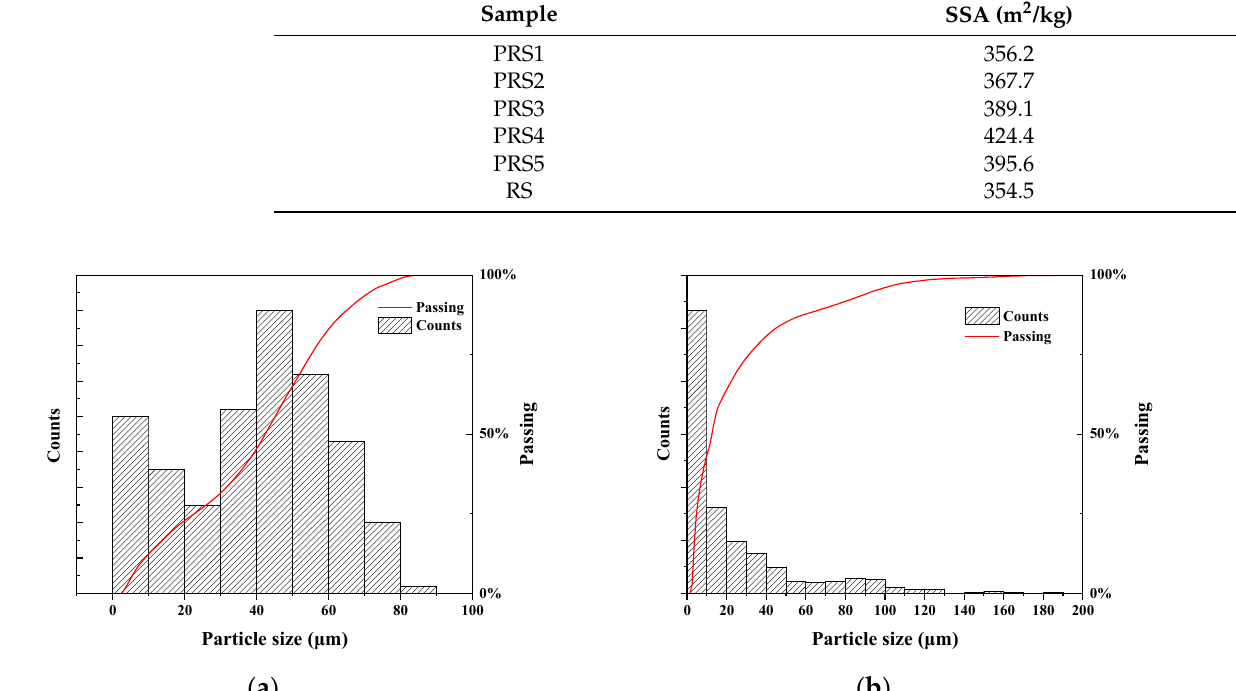
Table 6. SSA of porous reconstructed steel slag with different content of SiC.